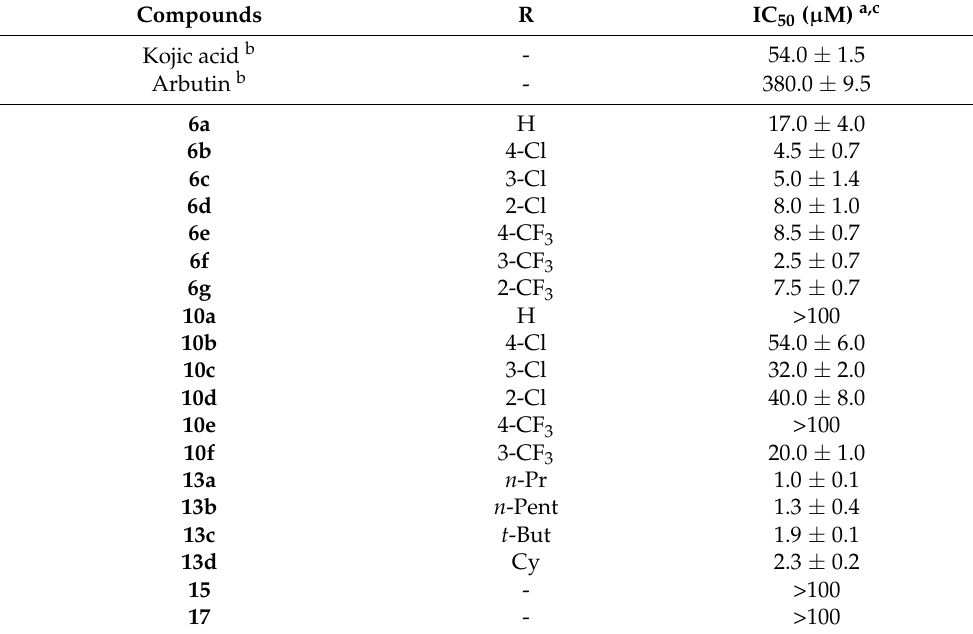
Table 1. Inhibitory activity of pyridine ( 6a – g ), pyrimidine ( 10a – f ), and cyclohexyl ester ( 13a – 13d , 15 and 17 ) analogues of CGA against α -MSH-induced melanogenesis in B16 melanoma